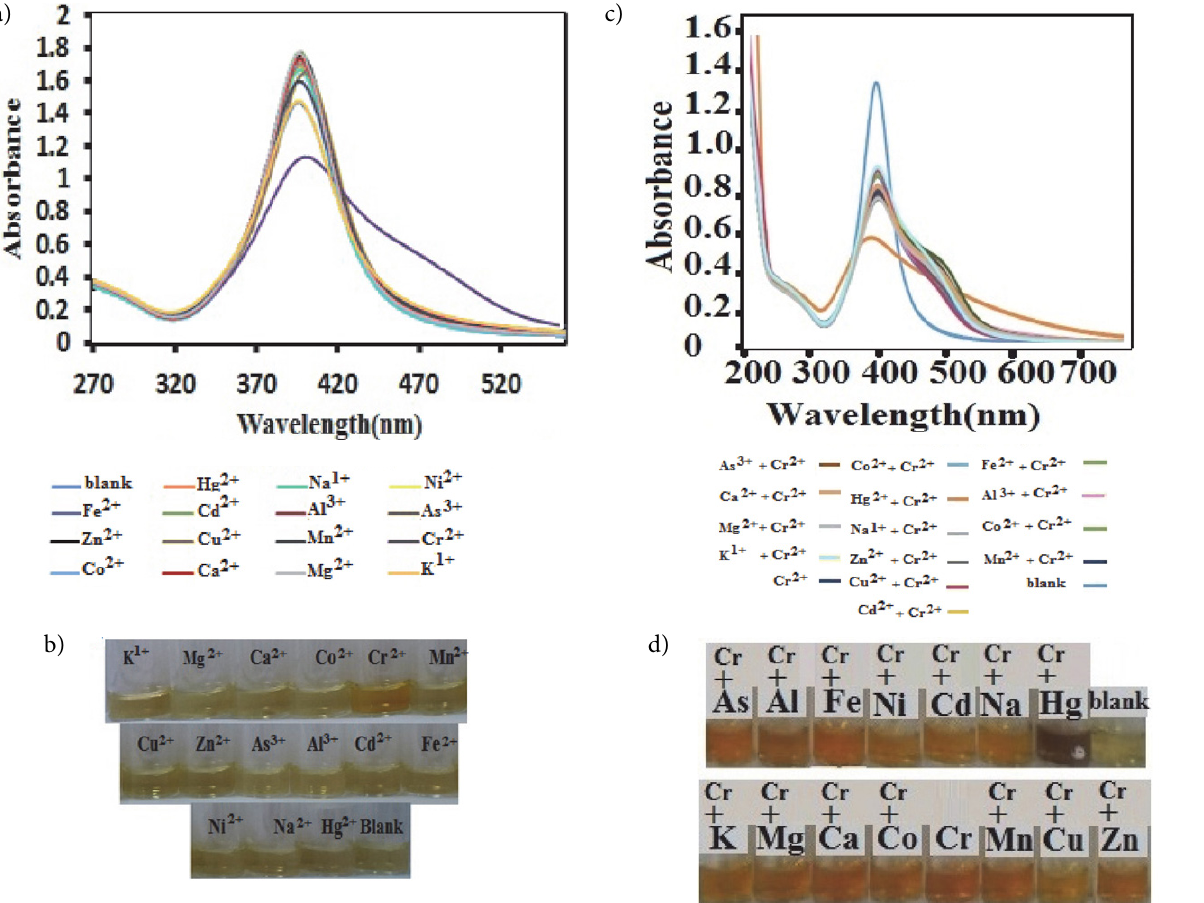
Figure 5. Selectivity of the SDS-AgNPs for Mn 2+ compared with other ions: (a) UV-vis spectra; (b) photographic images for detecting AgNPs incu- bated with K + (50 µM), Cu 2+ (50 µM), Hg 2+ (50 µM), or other ions (50 µM) at pH 7; (c) UV-vis spectra; and (d) Photographic image of detecting SDS-AgNPs incubated with mixture of Mn 2+ (5 µM) and other ions (5 µM) at pH